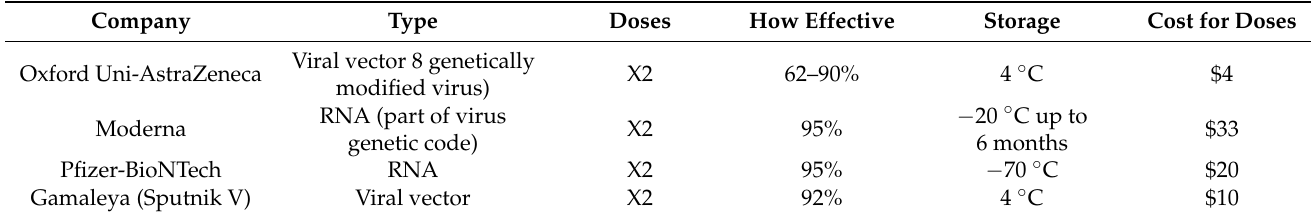
Table 1. Vaccines against COVID-19 currently in